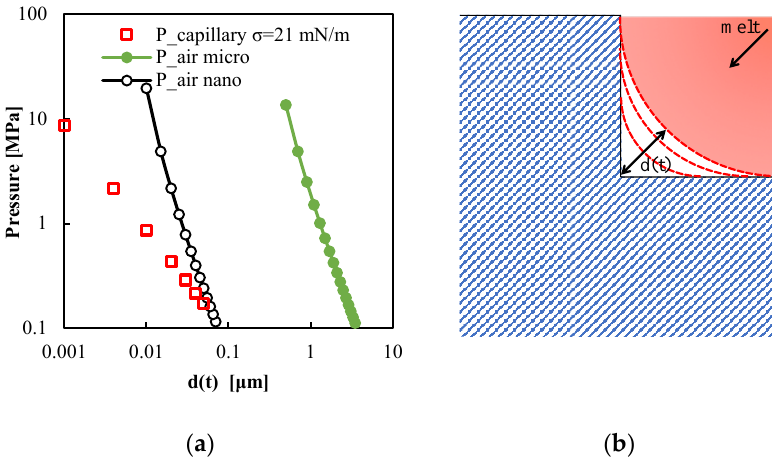
Figure 7. ( a ) Pressure due to the trapped air and to the surface tension as function of the unfilled distance d(t). ( b ) Sketch of the replication process viewed as the filling of a micro-cavity.